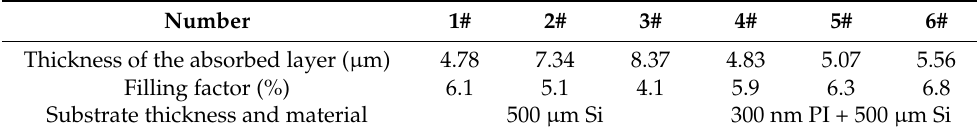
Figure 10. Photographs and SEM images of nanoaggregate samples. Samples #1–3 were formed on 500 μm Si substrates. Samples #4–6 were formed on 300 nm PI layer; PI layer was fabricated by spin-coating. Table 2. Structural parameters of nanoaggregate samples.